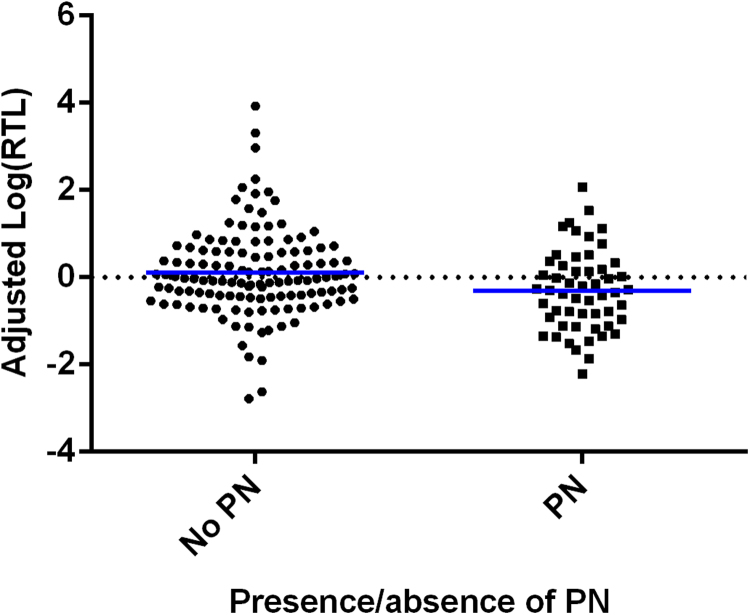
A plot showing log(RTL) adjusted for the effects of age, sex and study (y-axis) in those who have and have not experienced physical neglect (PN; x-axis). There was a significant decrease in adjusted log(RTL) amongst those who had experienced childhood physical neglect (p=0.007).